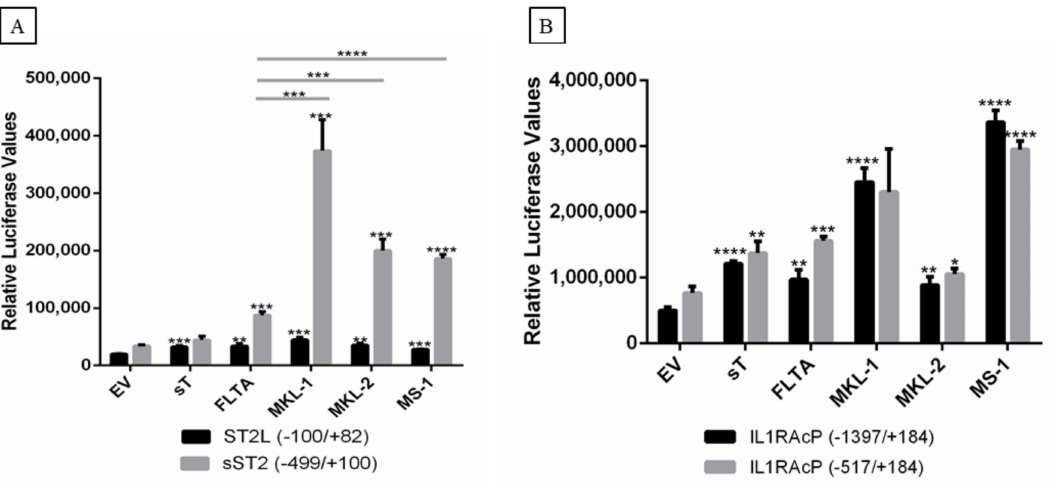
Figure 5. Effect of MCPyV T-ag on ST2/IL1RL1 and IL1RAcP promoter activity in MCC-13 cells. Cells were co-transfected with a luciferase reporter vector driven by ST2/IL1RL1 or IL1RAcP promoter sequences and full-length LT (LT), tLT (LT MKL-1 , LT MKL-2 , and LT MS-1 ), sT, or empty vector (EV). The promoter fragments spanning nucleotides for ST2/IL1RL1 were − 100/+82 and − 499/+100 ( A ) and for IL1RAcP they were − 1397/+184 and − 517/+184 ( B ). Luciferase activity was assessed following overnight cultivation of transfected cells. Each bar represents the average of three independent parallels +SD. Luciferase values were normalized to the total protein in each sample. * p ≤ 0.05, ** p ≤ 0.01, *** p ≤ 0.001, and **** p ≤